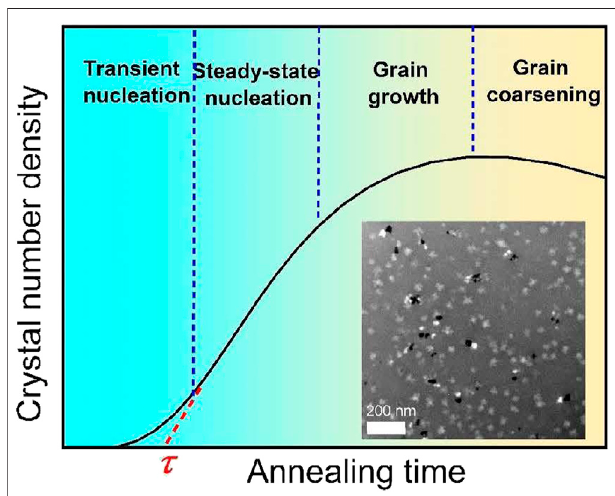
FIGURE1| ExperimentalmeasurementmethodbyTEMforthetransient nucleationdelaytime τ inMGs.First,basedontheTEMresultscorresponding to different annealing times, the plot of crystal number density and annealing time can be obtained. Then, extrapolating the steady state nucleation line as marked by red dashed line and the intersection point between the steady state nucleation line and the time axis is the delay time. The inserted picture gives one typical TEM image of the nanocrystal distribution in Al 88 Y 7 Fe 5 MG